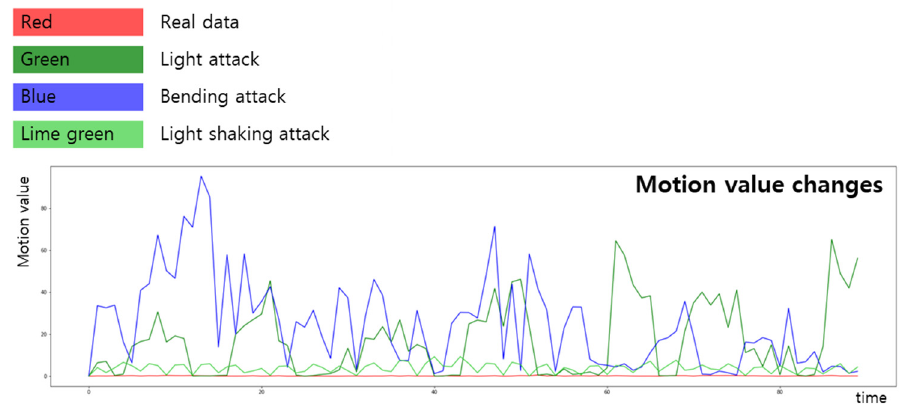
Figure 5. Motion value changes according to time domain.